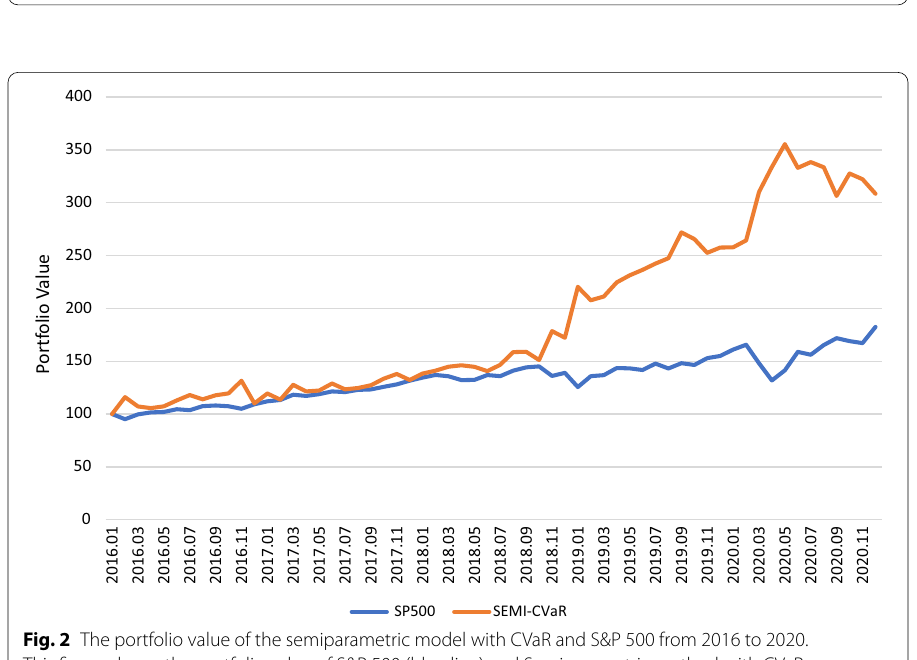
Fig. 2 The portfolio value of the semiparametric model with CVaR and S&P 500 from 2016 to 2020. This figure shows the portfolio value of S&P 500 (blue line) and Semiparametric method with CVaR ( α = 0.05, yelloline ) in five years (2016 to 2020). The initial value of portfolio is 100. It is clear that the semiparametric method has better performance in